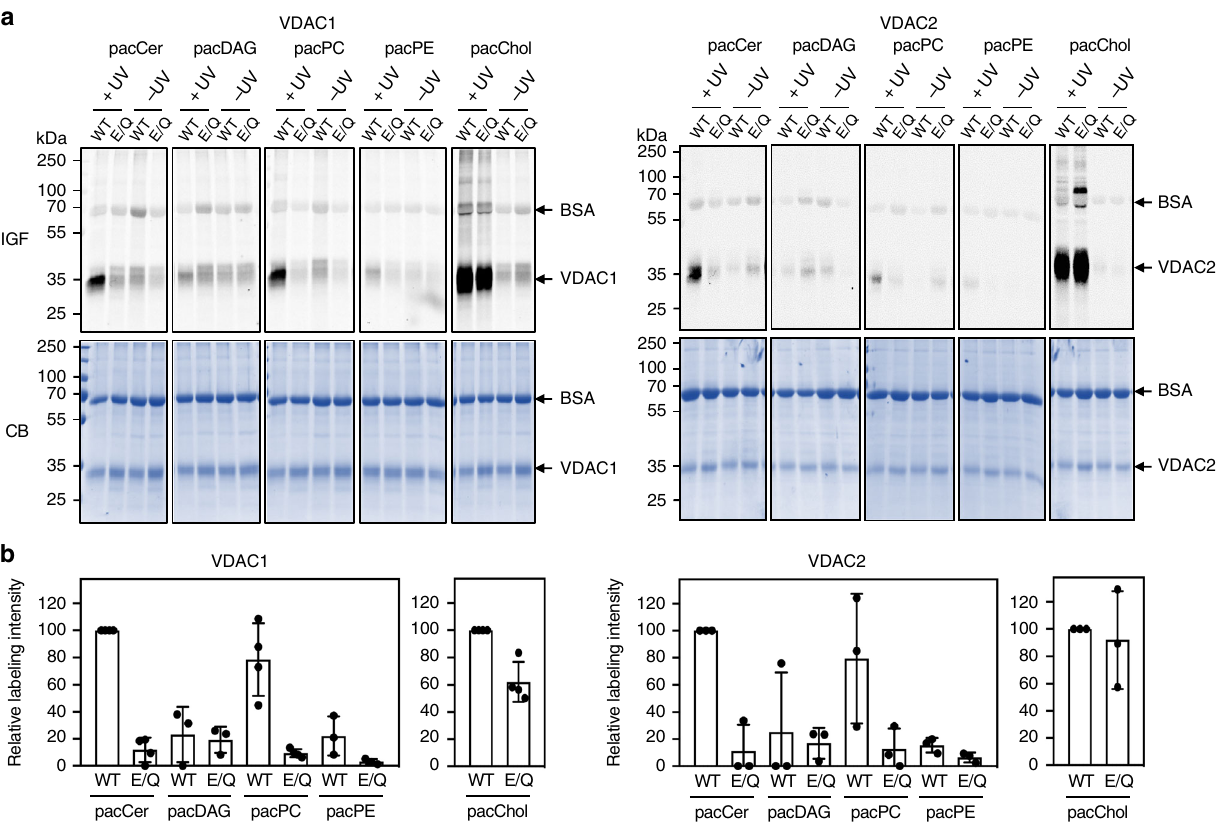
Fig. 4 The bilayer-facing Glu is a critical determinant of pacCer photolabeling of VDACs. a Human VDAC1, VDAC1 E73Q , VDAC2, and VDAC2 E84Q were produced in E. coli , puri fi ed, reconstituted in liposomes, and incubated for 30 min at 37 °C with liposomes containing 1 mol% of pacCer or photoactive and clickable analogs of diacylglycerol (pacDAG), phosphatidylcholine (pacPC), phosphatidylethanolamine (pacPE), or cholesterol (pacChol). Samples were UV irradiated and then click-reacted with AF647-N 3 , subjected to SDS-PAGE, and analyzed by IGF and CB staining. b Quantitative analysis of relative labeling ef fi ciencies of reconstituted VDAC1, VDAC1 E73Q , VDAC2, and VDAC2 E84Q with pacLipids as indicated in a . Data are means ± s.d.; n ≥ 3. Source